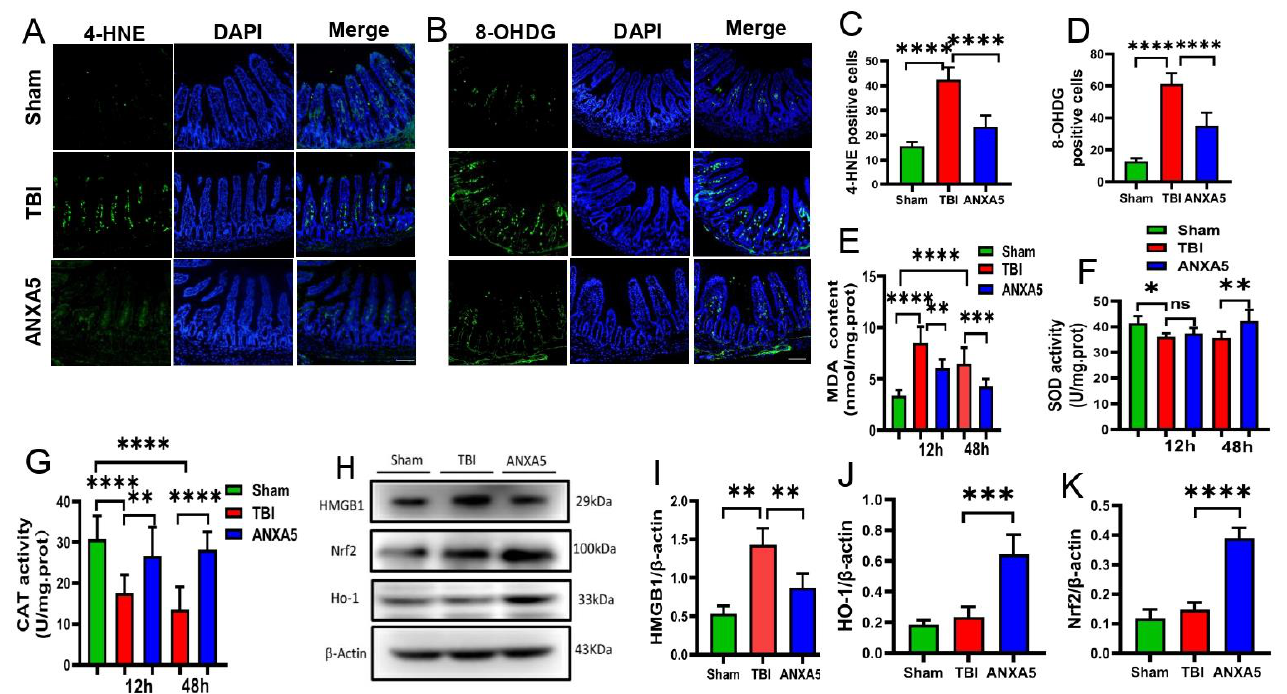
Figure 4. ANXA5 attenuated oxidative stress and enhanced antioxidant activity in the intestine after TBI. ( A – D ) Immunofluorescence showed that ANXA5 dramatically reduced the numbers of 4-HNE and 8-OHDG-positive cells (in green) in the intestine on day 2 after TBI. Insets show merged images of 4-HNE and 8-OHDG staining with DAPI-stained nuclei (scale bar = 100 µ m). n = 6 mice/group. ( E – G ) ANXA5 significantly increased SOD and catalase activity and reduced the level of MDA in the intestine at 0.5 and 2.0 days after TBI ( n = 6 mice/group). ( H – K ) Western blotting showed that ANXA5 significantly decreased HMGB1 expression ( n = 6 mice/group) and increased the levels of Nrf2 ( n = 6 mice/group) and the downstream molecule HO-1 ( n = 6 mice/group). Data are shown as mean ± SD. * p < 0.05, ** p < 0.01, *** p < 0.001, **** p < 0.0001.